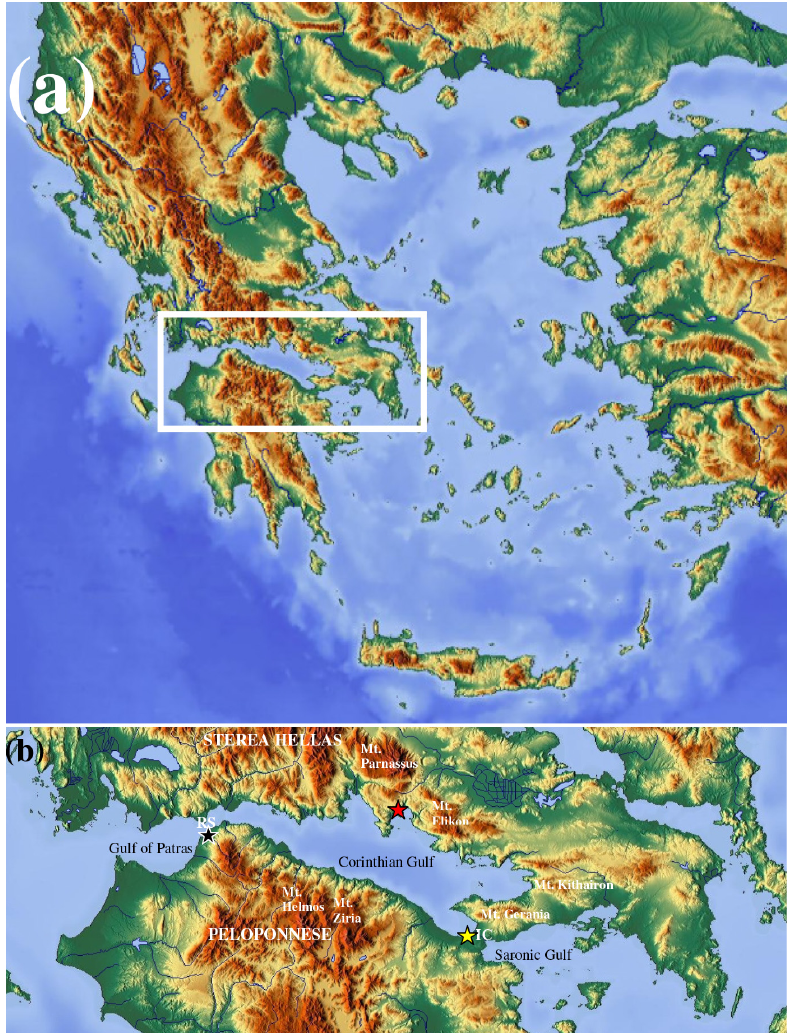
Fig. 1. ( a ) Map of Greece: the white box indicates the location of the Corinthian Gulf. ( b ) Topographical details of the white box area of ( a ), in which the major topographical elements as well as the adjacent gulfs are shown. RS refers to Rio Strait and IC to Isthmus of Corinthos. The colored five-point stars show the location of the ground meteorological stations along the coast of the Corinthian Gulf (black: Rio; red: Antikira; and yellow: Isthmus of